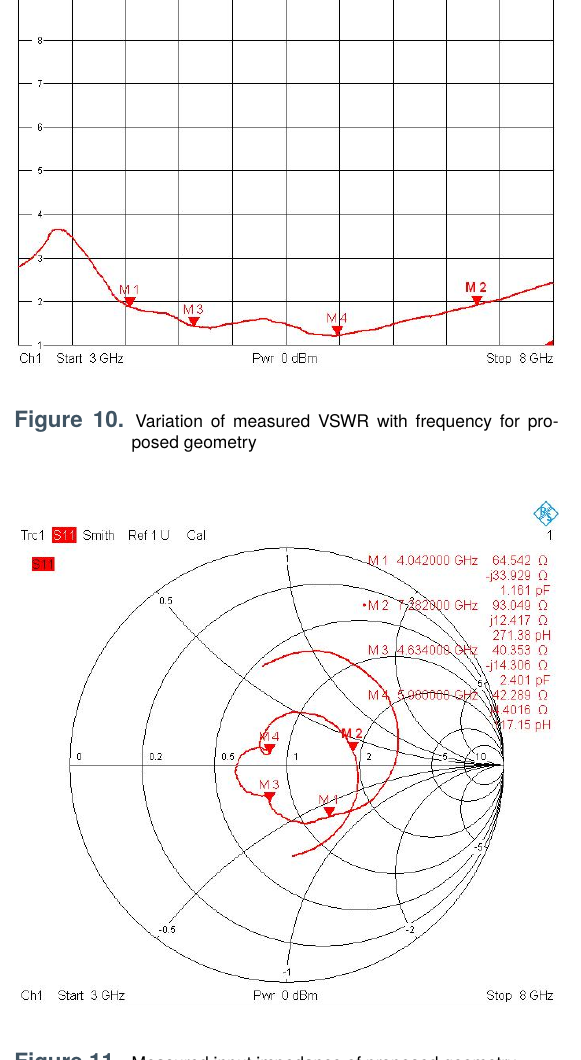
shown in figure 10. The measured input impedance re- lated to two resonant frequencies are (42.35- j4.80) ohm and (42.28+j4.406) ohm respectively as shown in figure 11 which are nearly reaching to 50 ohm impedance of the microstrip feed line.